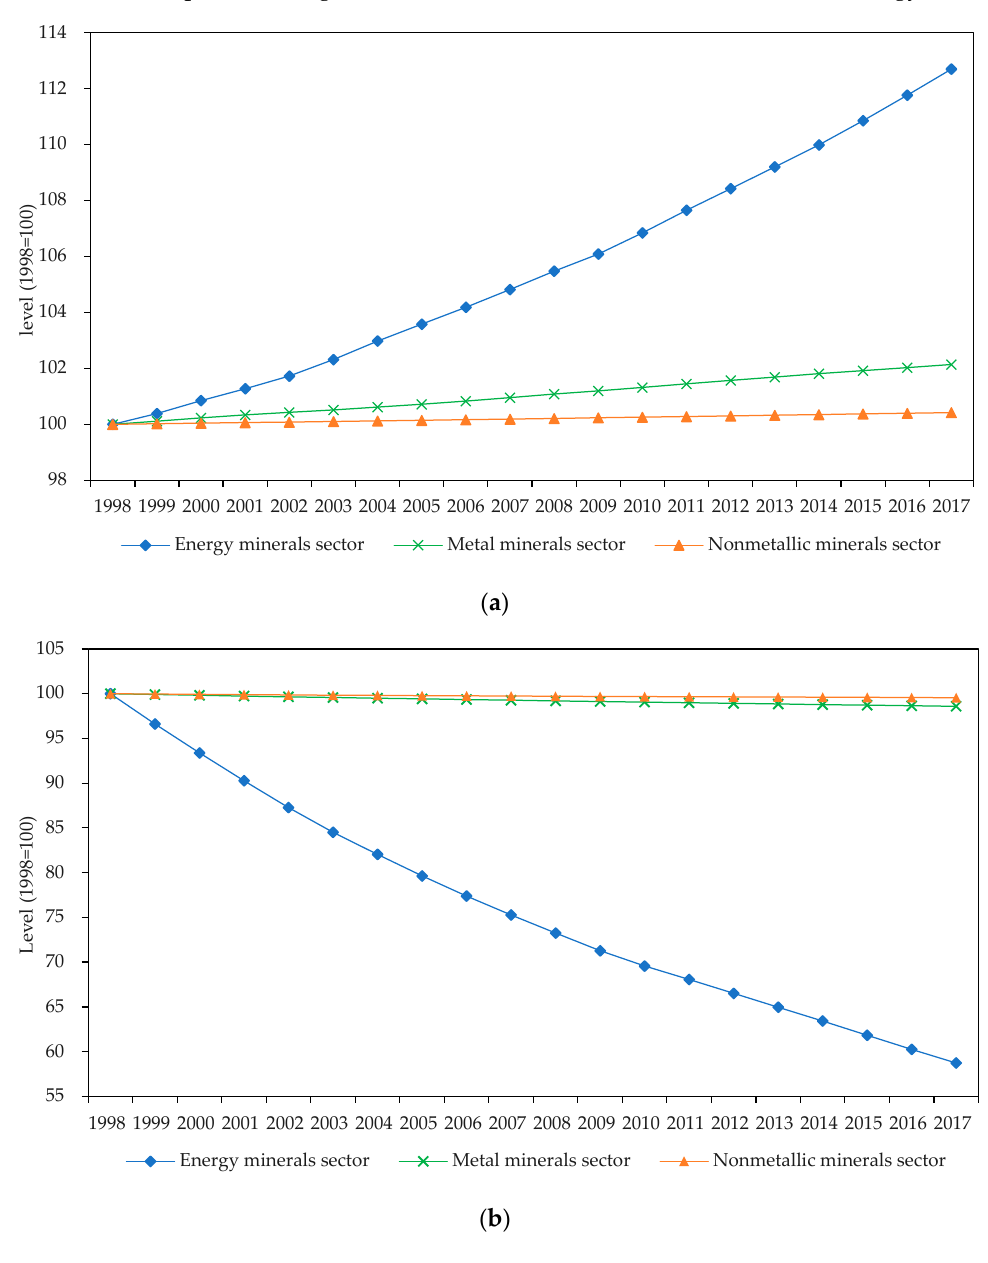
Figure 3. Cumulative green factor bias of technological progress by sectors (1998 = 100) showing ( a ) resource factor bias of technological progress by sectors and ( b ) environmental factor bias of technological progress by sectors.